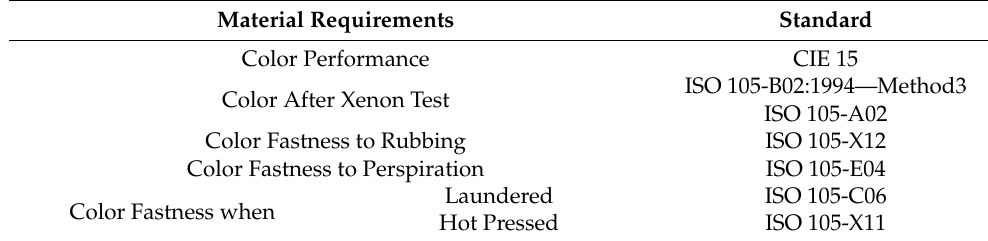
Table 2. Material Requirements according to